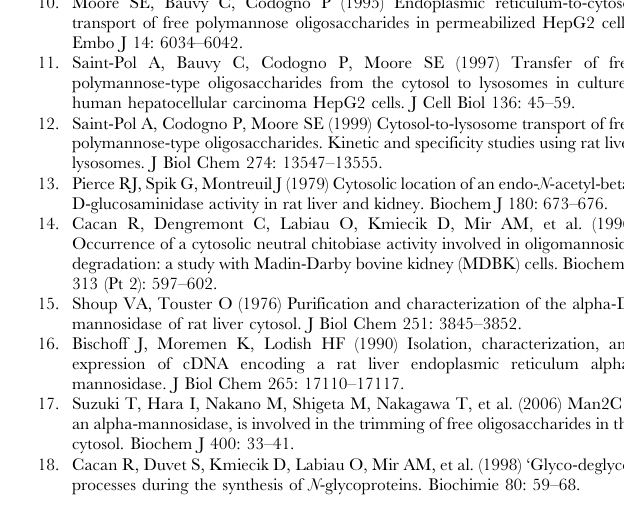
Figure S2 Effects of the inhibition of Man2C1 gene expression on fOS metabolism - (A) Kinetics of inhibition of Man2C1 transcripts by 3 siRNA duplexes. HepG2 cells were transiently transfected with 25 pmoles of 3 different short interfering RNA sequences (M2C1-1, M2C1-2 and M2C1-3) targetting the cytosolic Man2C1 mannosidase. 1, 2 and 3 days